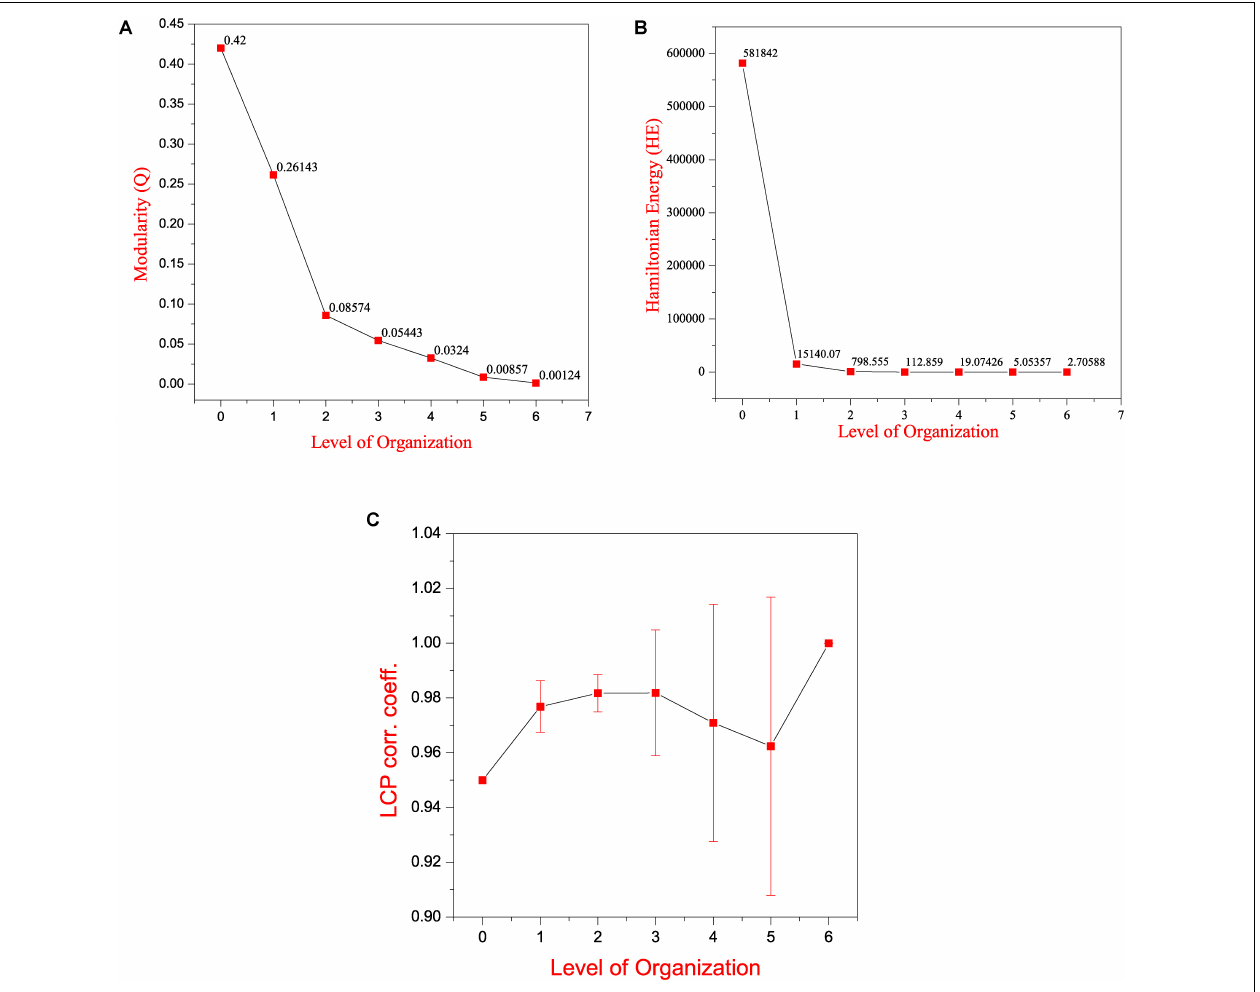
FIGURE 5 | Features of the SB network (A) modularity (Q) plotted against levels of the hierarchical organization of the SB network. (B) Hamiltonian Energy (HE) plotted against levels of the hierarchical organization of the SB network. (C) variation in the calculated average LCP-corr coefficient as a function of levels of the hierarchical organization of the SB